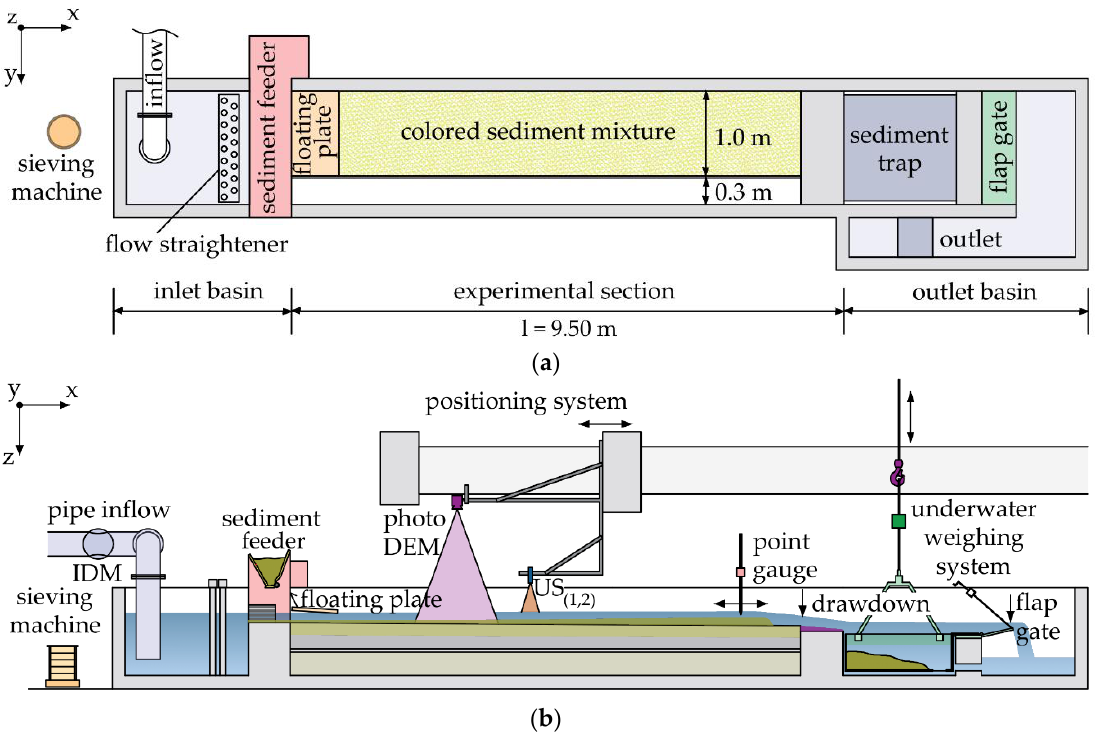
Figure 1. Experimental setup, ( a ) plan view; ( b ) longitudinal section of the straight flume. DEM = digital elevation model, US = ultrasonic probe.